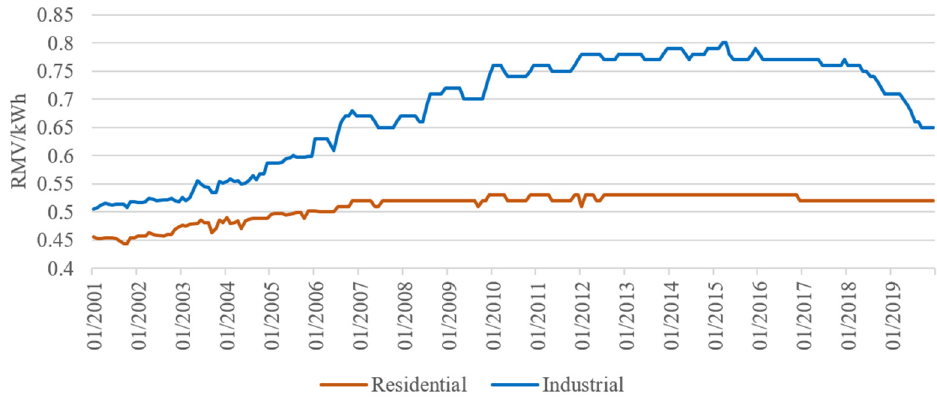
Figure 5. A total of 36 city average electricity prices in China. Prices are in RMB/kWh. Data source: CEIC database. Data reported cover the period January 2010–December 2019.